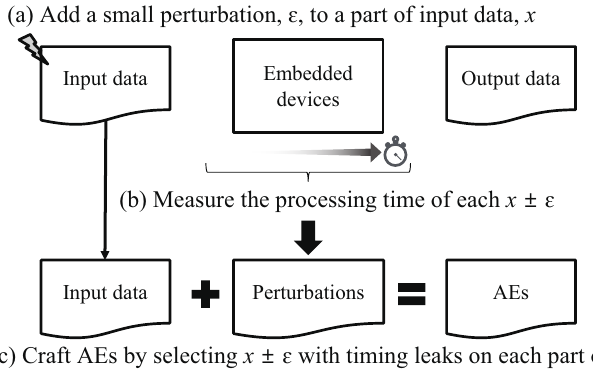
Figure 8: Strategy of timing black-box attacks for AEs